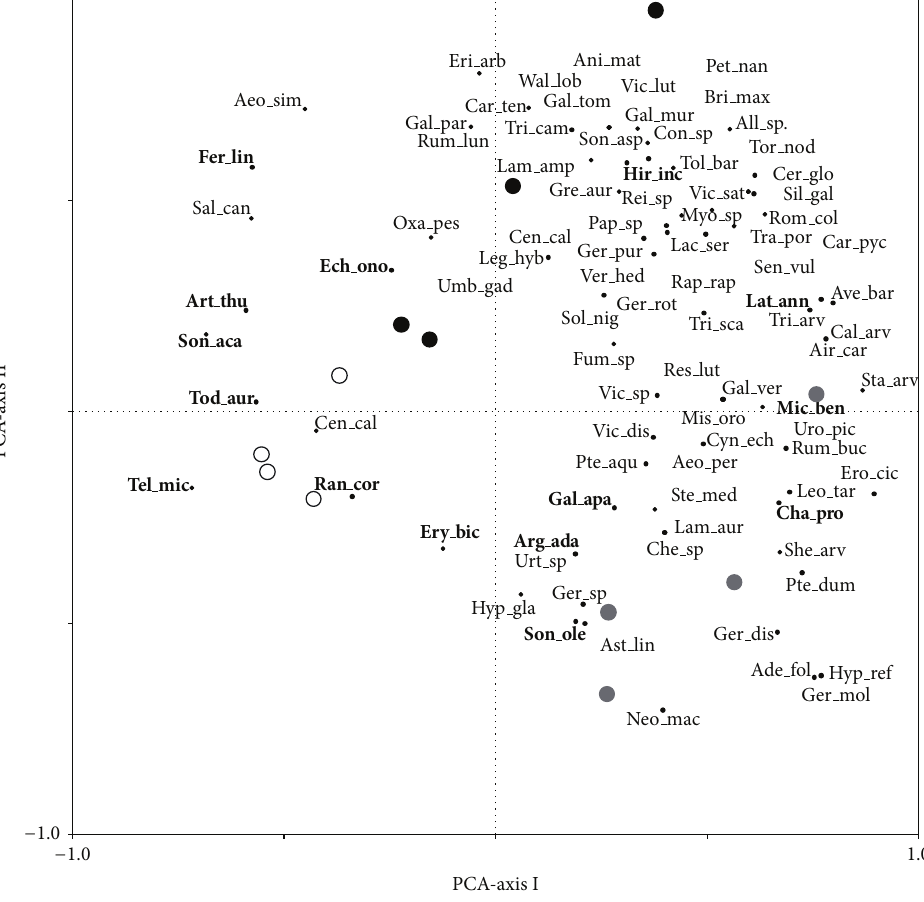
Figure 1: Principal component analysis ordination diagram showing species and samples according to treatment. Species that play consistent roles (SIMPER; mean dissimilarity to SD ratio higher than 1) in determining the dissimilarity between treatments (Table 5) are shown in bold. Species name abbreviations are shown in Table 4. Eigenvalues for the first and second axes were 0.27 and 0.18, respectively. Cumulative percentage variance of species data for both axes was 44.8. Only species with a fit range higher than 10% are shown. Control plots (white circle); burnt plots (black circle); cut plots (brown circle).